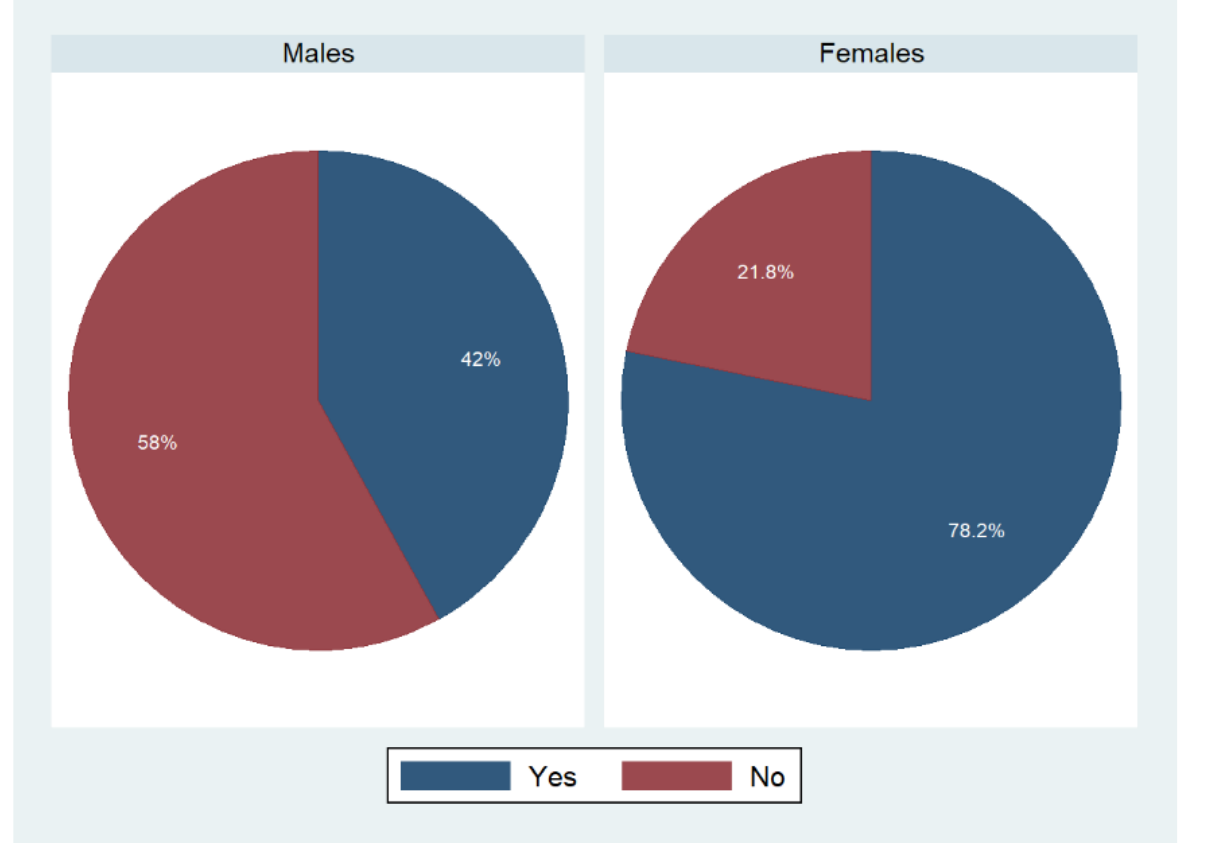
Figure 2. Shopping for food in families stratified by gender: an overview. Weighted proportions, n = 9087; p < 0.001 based on a Rao–Scott test exploring potential associations between main person shopping and sex.